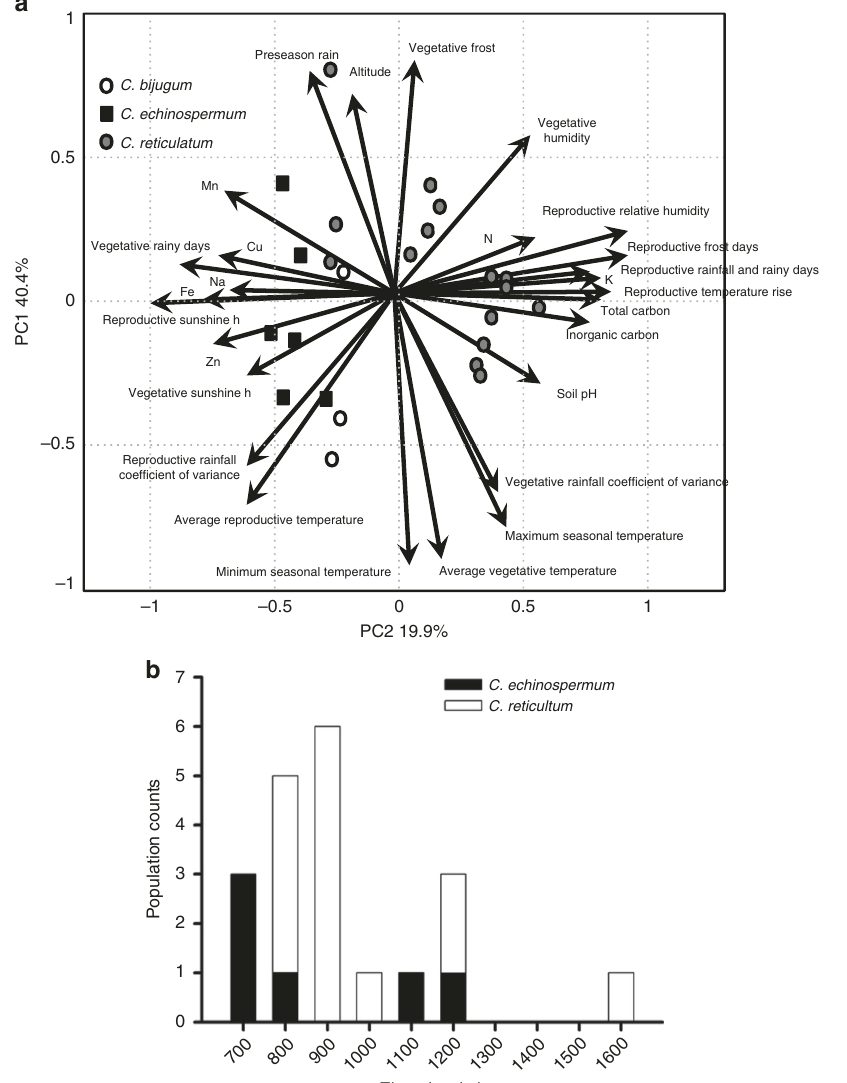
Fig. 3 Elevation is an important axis of environmental variation for wild Cicer . a Principal components analysis of 18 soil factors and 19 bioclimatic variables for each collection site. Arrows indicate loadings of each variable, while points indicate collection sites. b Elevation of collection fi eld sites were separated from C. echinospermum and C. bijugum fi eld sites by less frequent rainfall in the vegetative phase, and a